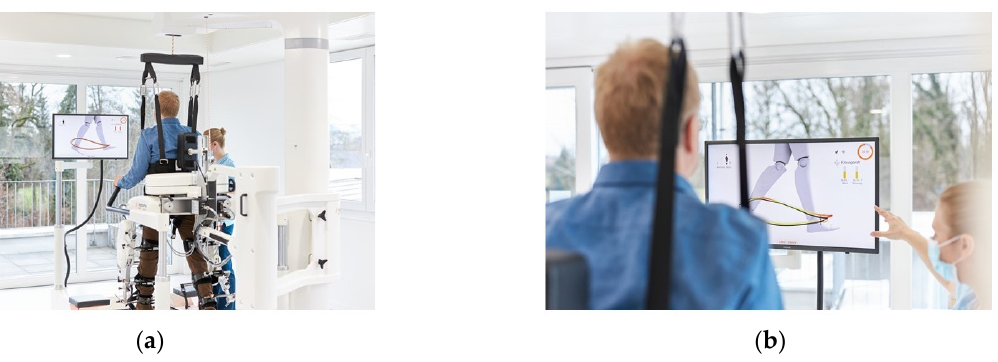
Figure 1. ( a ) Patient training with adaptive gait support (AGS) during Lokomat training. ( b ) AGS display. Image credit: Hocoma AG, www.hocoma.com